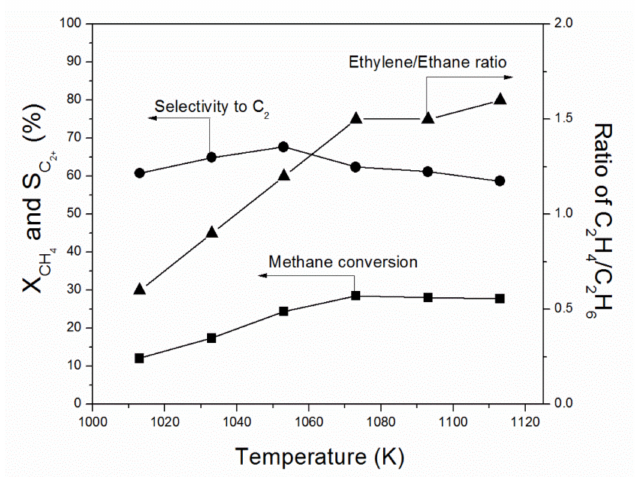
Figure 4. The influence of temperature on the OCM process. Source of methane—“biogas 1”. Reaction conditions: GHSV = 11550 cm 3 · g − 1 cat · h − 1 ; m cat = 400 mg; molar ratio of CH 4 :O 2 :CO 2 :He + N 2 = 3.3:1:1.2:12.4; total flow rate = 77 cm 3 · min − 1 .